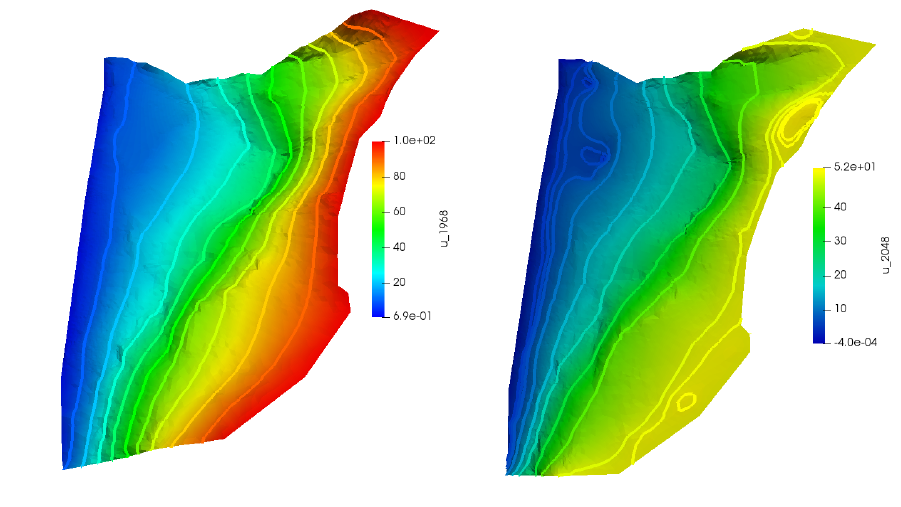
Figure 11. Plan view of the piezometry of the plain Souss–Chtouka before ( left ) and after ( right )